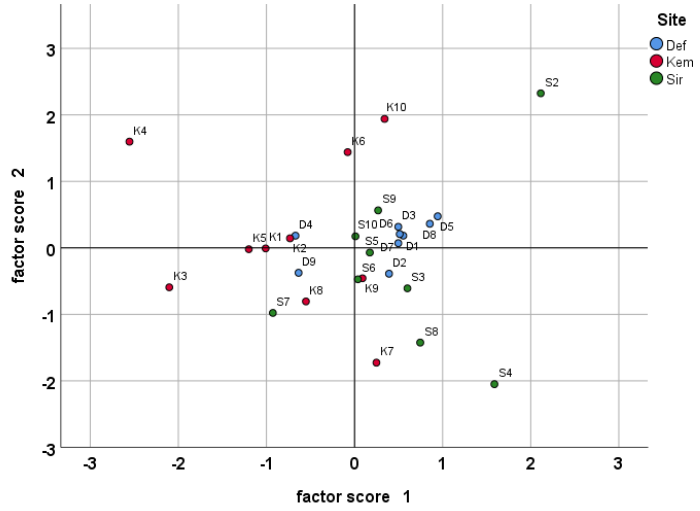
Figure 2. PCA scoring plot showing the essential oil samples from the individual P. cembra trees.